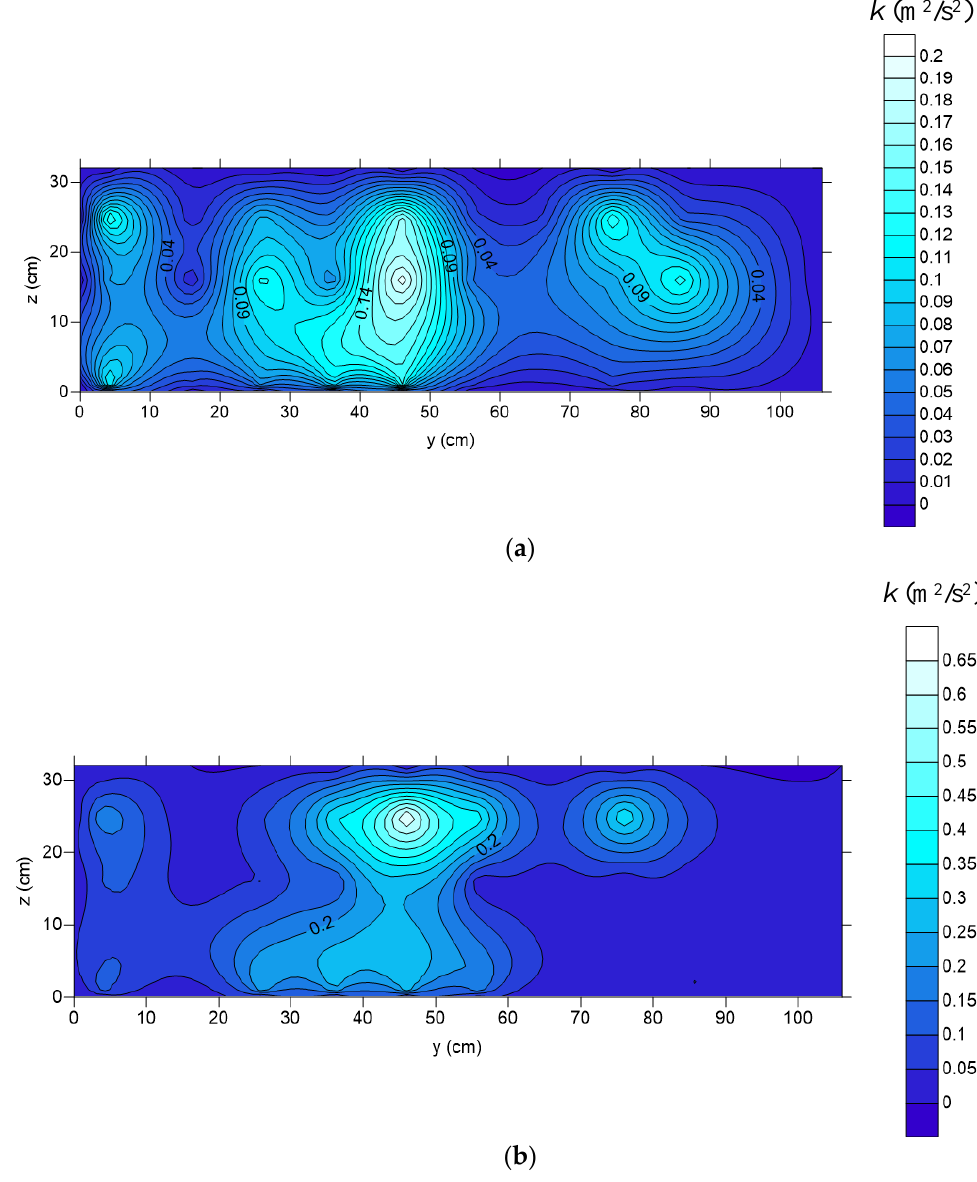
Figure 12. Distribution of TKE in vertical section E for ( a ) Q = 0.187 m 3 /s and d/h = 0.92, and ( b ) Q = 0.264 m 3 /s and d/h = 1.08.